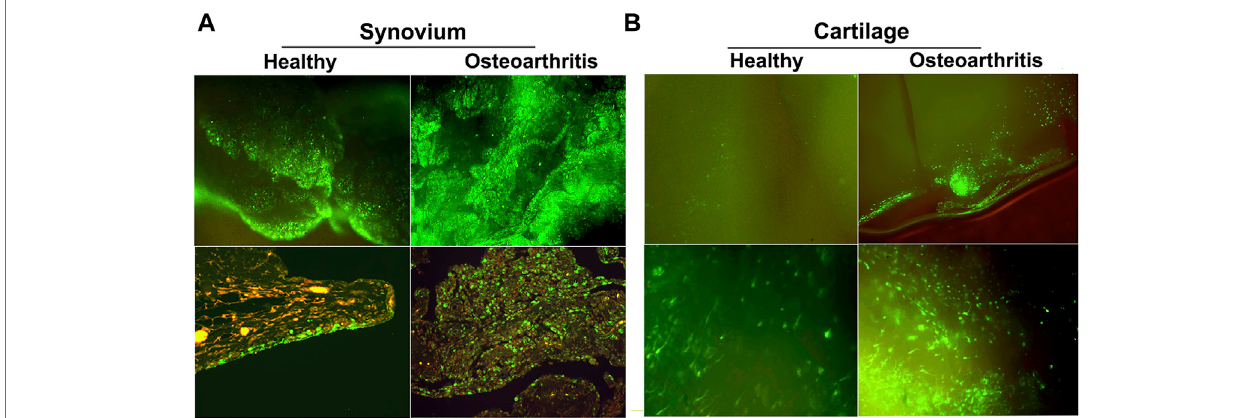
FIGURE 5 | GFP expression in healthy and OA joints following intra-articular gene delivery with scAAV. The middle carpal joints of 3 healthy horses and 3 with late stage naturally-occurringOAwereinjected with5×10 12 vgofscAAV.GFP.Twoweekslater thejointtissueswerecollectedand analyzedfor fl uorescence. (A) (Toprow) Fluorescenceactivityinfreshlyharvestedsynovialtissuesviewedwithinverted fl uorescencemicroscopyat×10magni fi cation.(bottomrow)Paraf fi nsectionsofsynovium immunohistochemically stained for GFP at ×20 magni fi cation. In normal joints, the synovium was the predominant site of transgene expression, with abundant fl uorescentcellsscatteredthroughoutthecapsularlining,oftenconcentratedinthickervillousregions.Instrikingcontrast,thenumberanddensityofthe fl uorescentcells in OA joints were visibly greater across the entire expanse of the synovial lining, but particularly so in regions with marked hyperplasia and leukocytic in fi ltration. In both normal and OA joints the transduced cells were almost exclusively delimited to the synovium and subsynovium, and only rarely seen in the supporting fi brous tissues. (B) GFP expression in fresh cartilage shavings viewed with inverted fl uorescence microscopy. Images in the top and bottom rows are at ×10 and ×20 magni fi cation, respectively. In articular cartilage from normal joints, GFP fl uorescence was visible but generally faint and limited to scattered isolated cells. In OA cartilage, GFP activity was dramatically enhanced, as populations of brightly fl uorescent cells were readily apparent in all shavings recovered. The labeled chondrocytes included both elongated cells, consistent with super fi cial layer chondrocytes, and cells with more spherical morphology characteristic of chondrocytes in deeper layers. Shavings harvested near full thickness erosions often contained focal regions with intense fl uorescence readily visible at low magni fi cation.